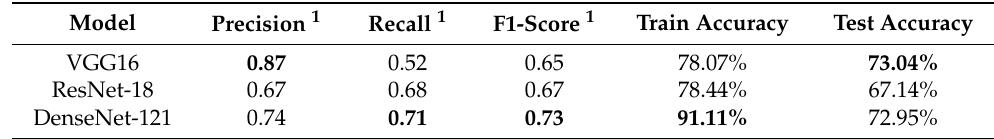
Table 2. Performance evaluation on the test and train sets for DR